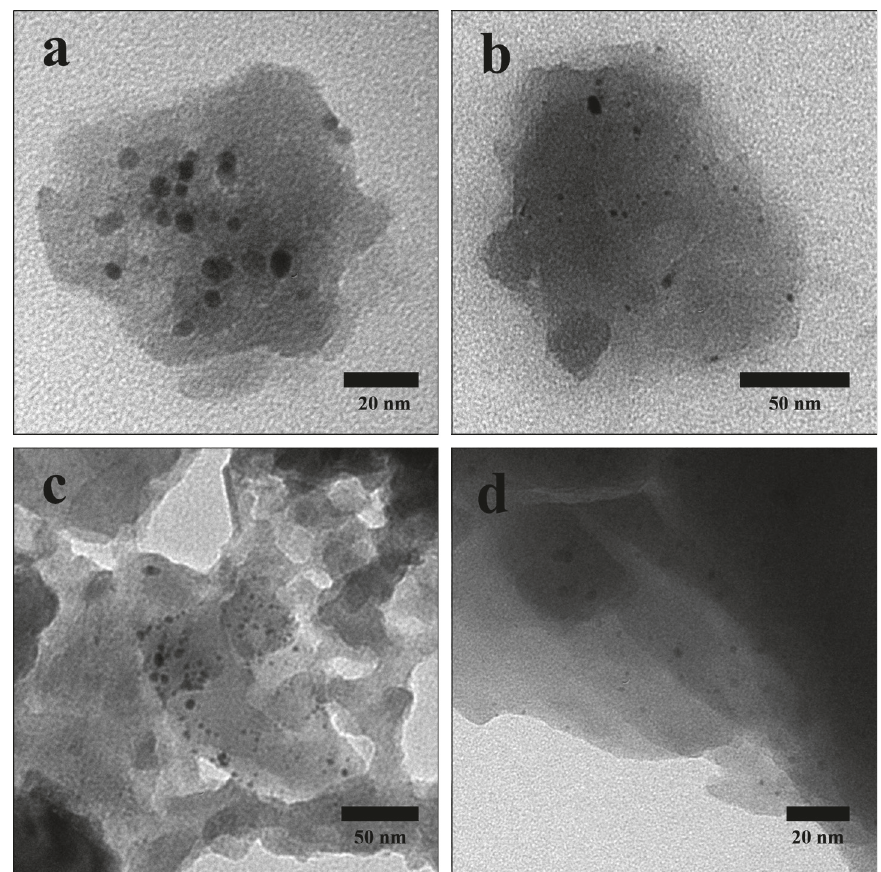
Figure 3: TEM images of the as-prepared catalysts: (a) 1% Pt/MORn; (b) 1% Pt/MORn-H; (c) 1% Pt/MORn-OH; (d) 1% Pt/MORn-H-OH.